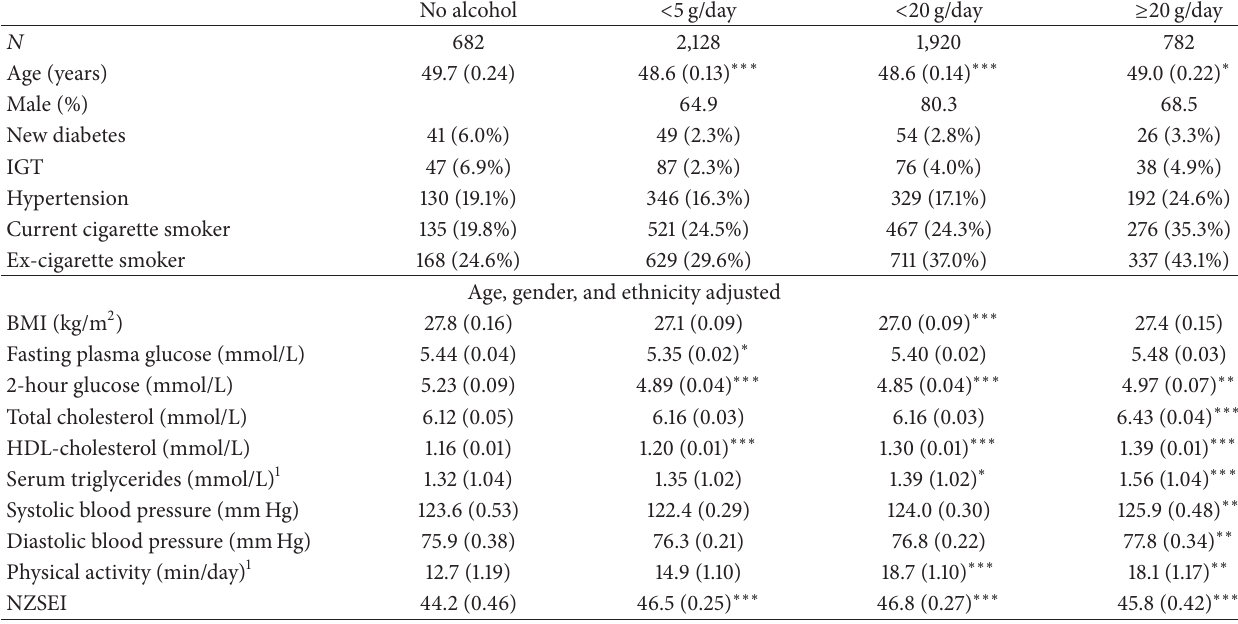
Table 2: Characteristics of participants by alcohol consumption levels in employed men and women, 1988–1990. No alcohol